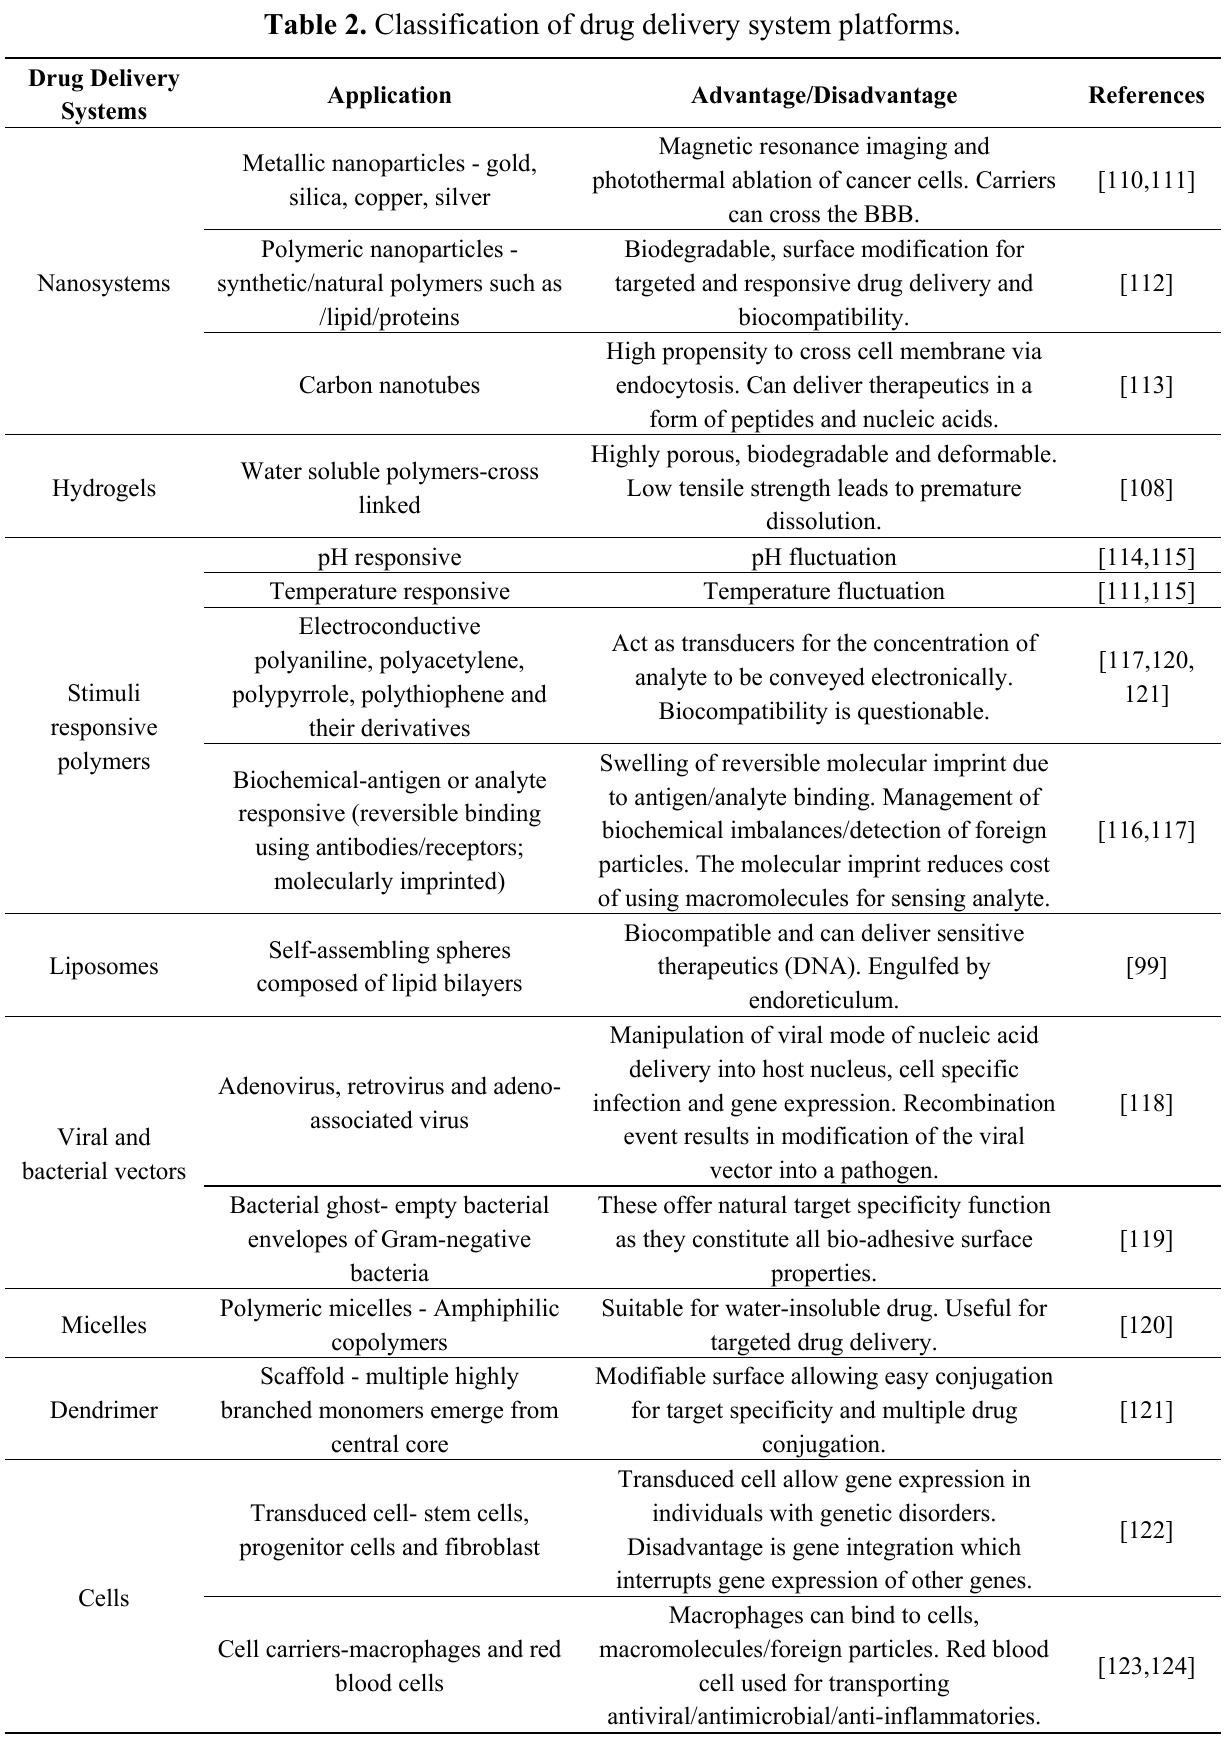
Table 2. Classification of drug delivery system